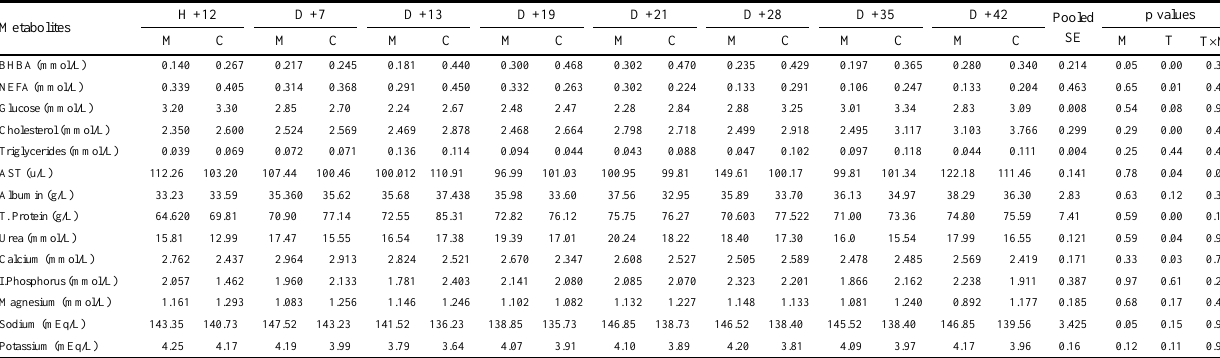
Table 4. Comparison of least square of means (LSMs) and standard errors (SEs) of serum constituents among lactating Saanen goats receiving monensin and controls not fed monensin during the post-parturition period (within 42 d after parturition)